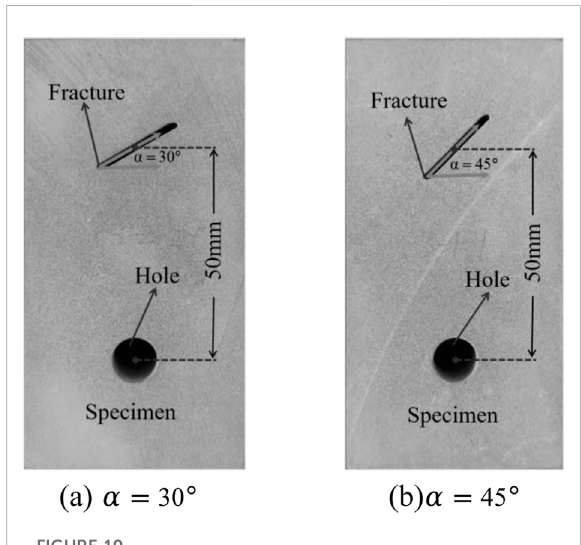
FIGURE 10 Geometric shape of single fracture-hole rock specimen